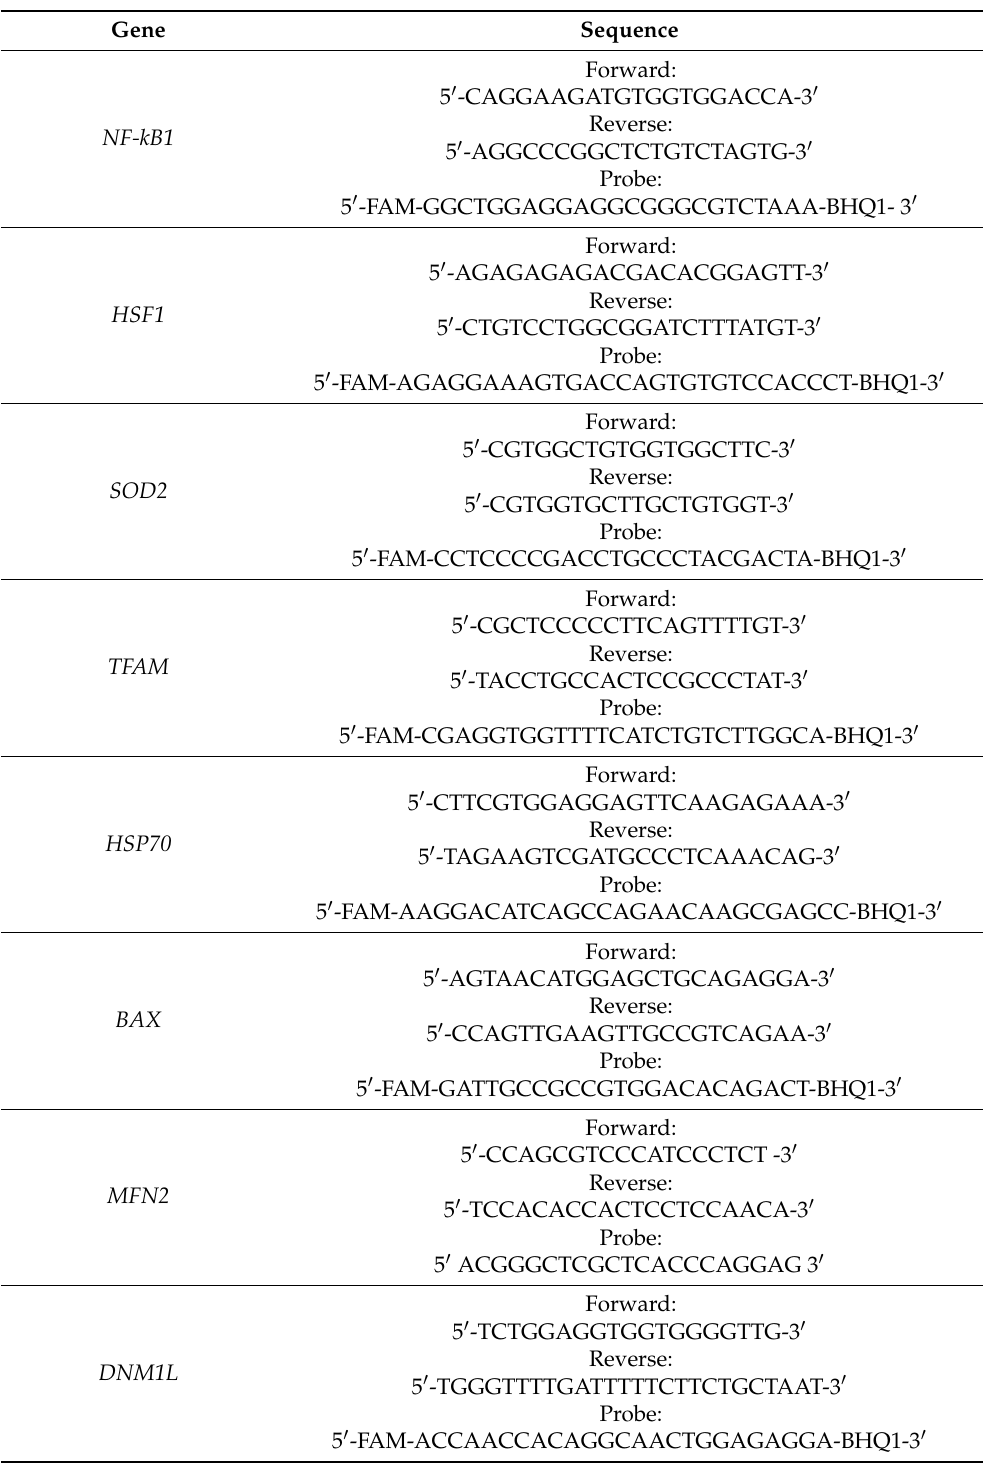
Table 1. Sequences of primers and probes for